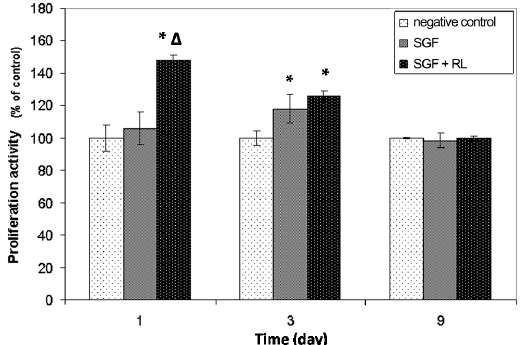
Figure 5. Proliferation activity of L929 cells cultured in different chambers, measured by the 3-[4,5- dimethylthiazol-2-yl]-2,5-diphenyl tetrazolium bromide (MTT) assay. “negative control”: 4-well